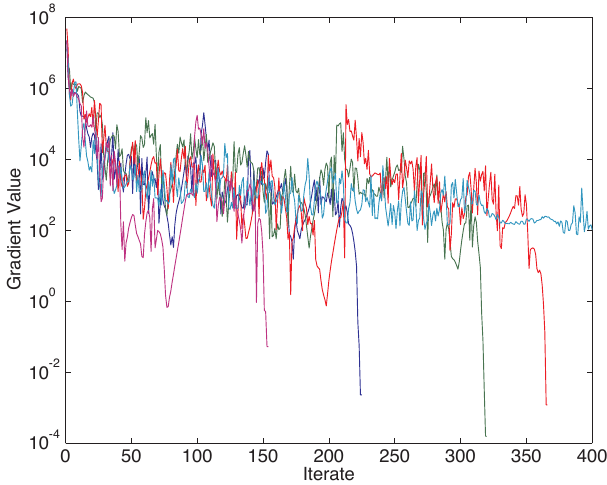
Figure 3. Gradient value for all five experiments in log scale up to 400 iterations (dark blue: Gaussian, green: log, red: quadratic, light blue: constrained, pink: penalty).